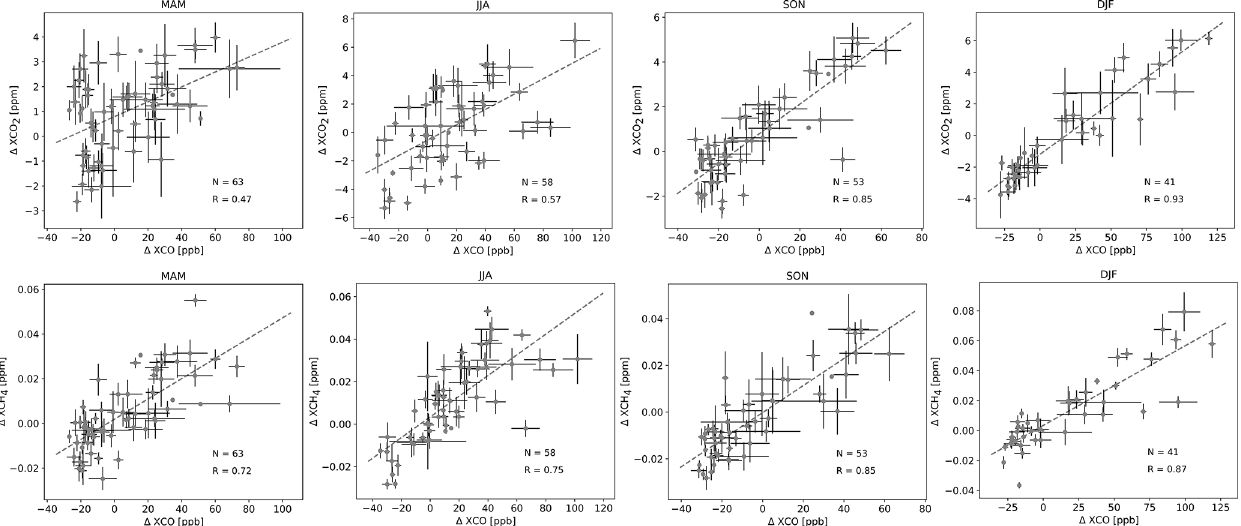
Figure 11. Upper panels: the correlation plots between the (cid:49) XCO and (cid:49) XCO 2 in four seasons (spring: March, April, May – MAM; summer: correlation plots between the (cid:49) XCO and (cid:49) XCH 4 in four seasons. The dashed line is the linear fit. N is the number of the measurement days, and R is the correlation coefficient. The error bar is the SD of the measurements in each